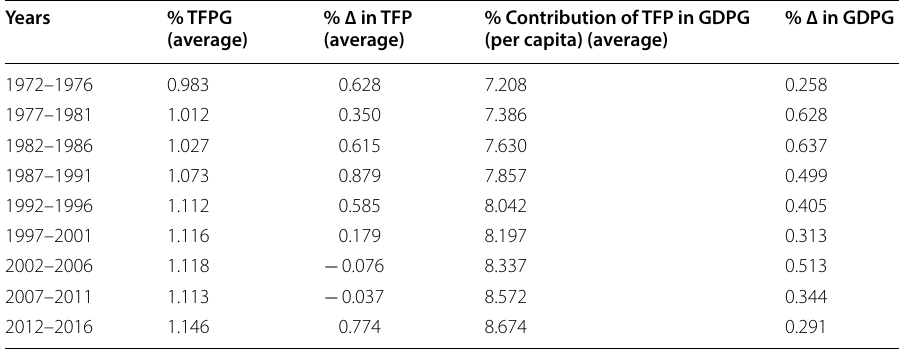
Results are presented in percentage (%). Results are based on Eqs. (2) and (4)